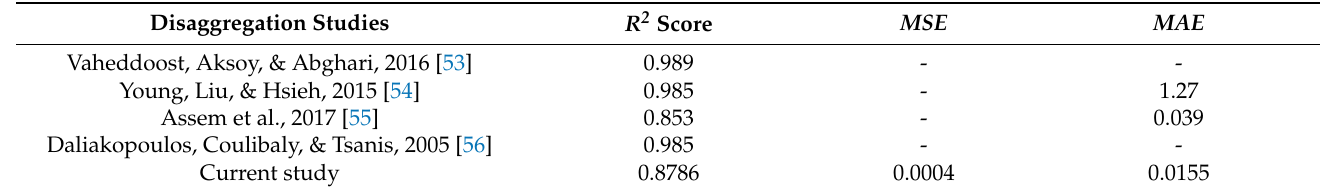
Table 6. Comparison of perdition performance of the LSTM model with existing